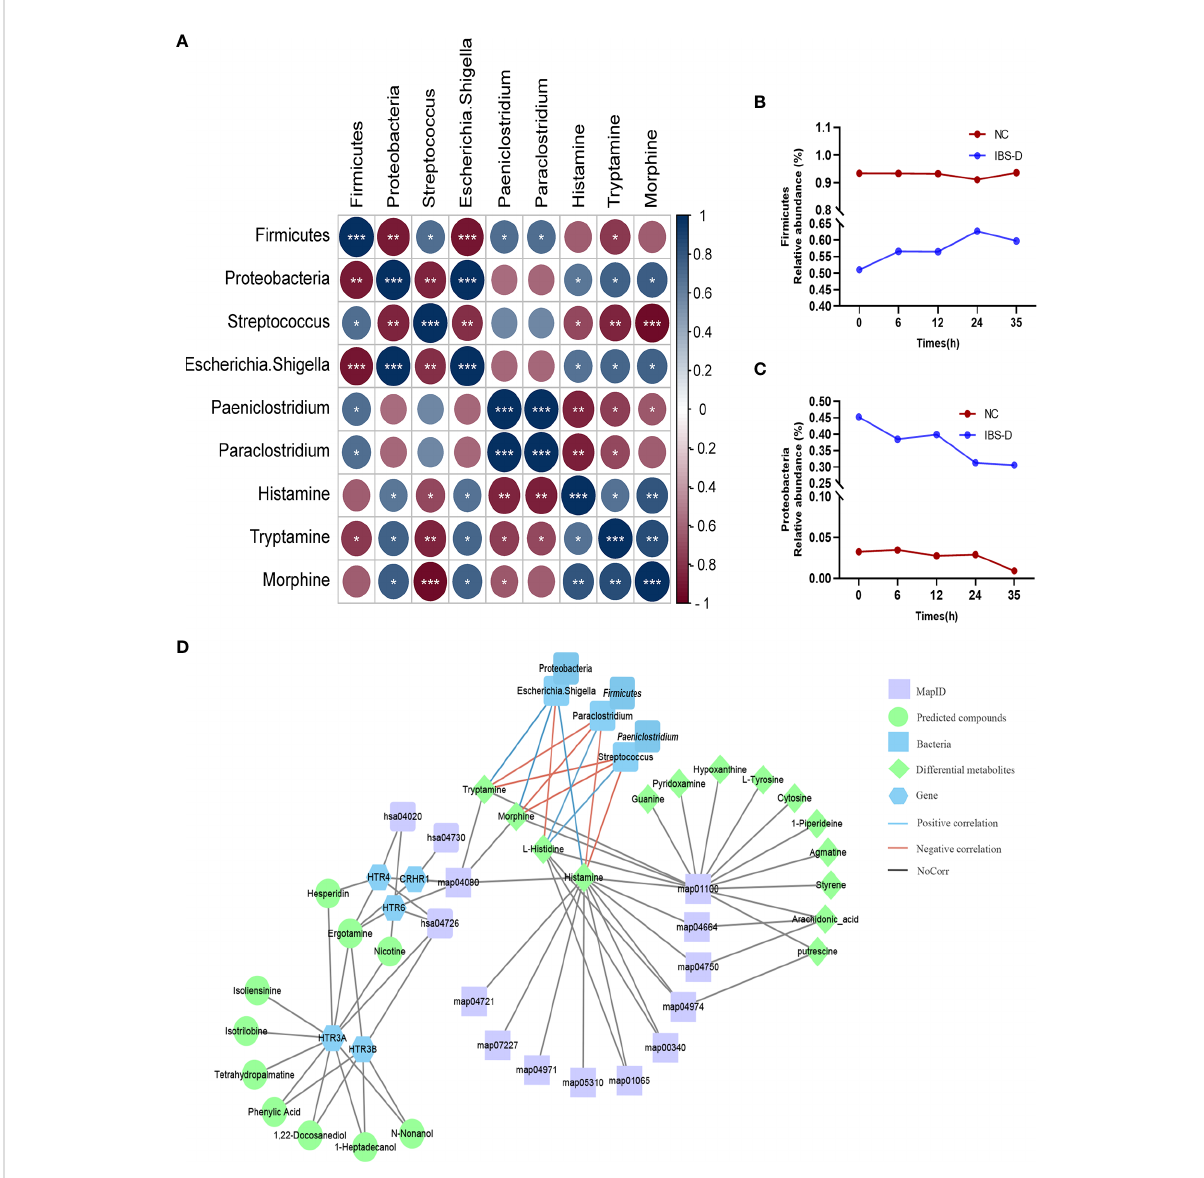
FIGURE 4 Signi fi cant correlations between microbiota and metabolites. (A) Correlation analysis of intestinal microbiota and differentially expressed metabolites. (B, C) . Time series of relative abundances of the phyla Proteobacteria (B) and Firmicutes (C) in a cocultivation system.